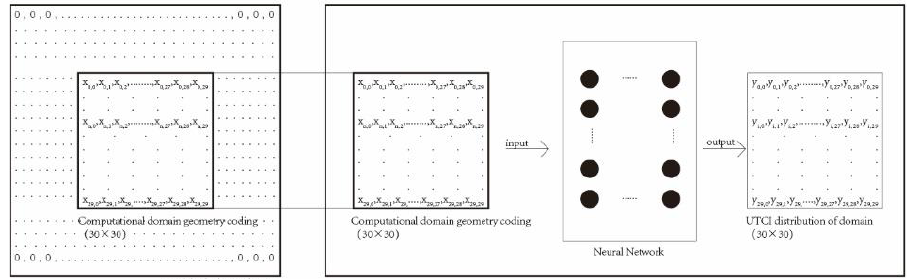
Figure 5. Schematic diagram of Group A.